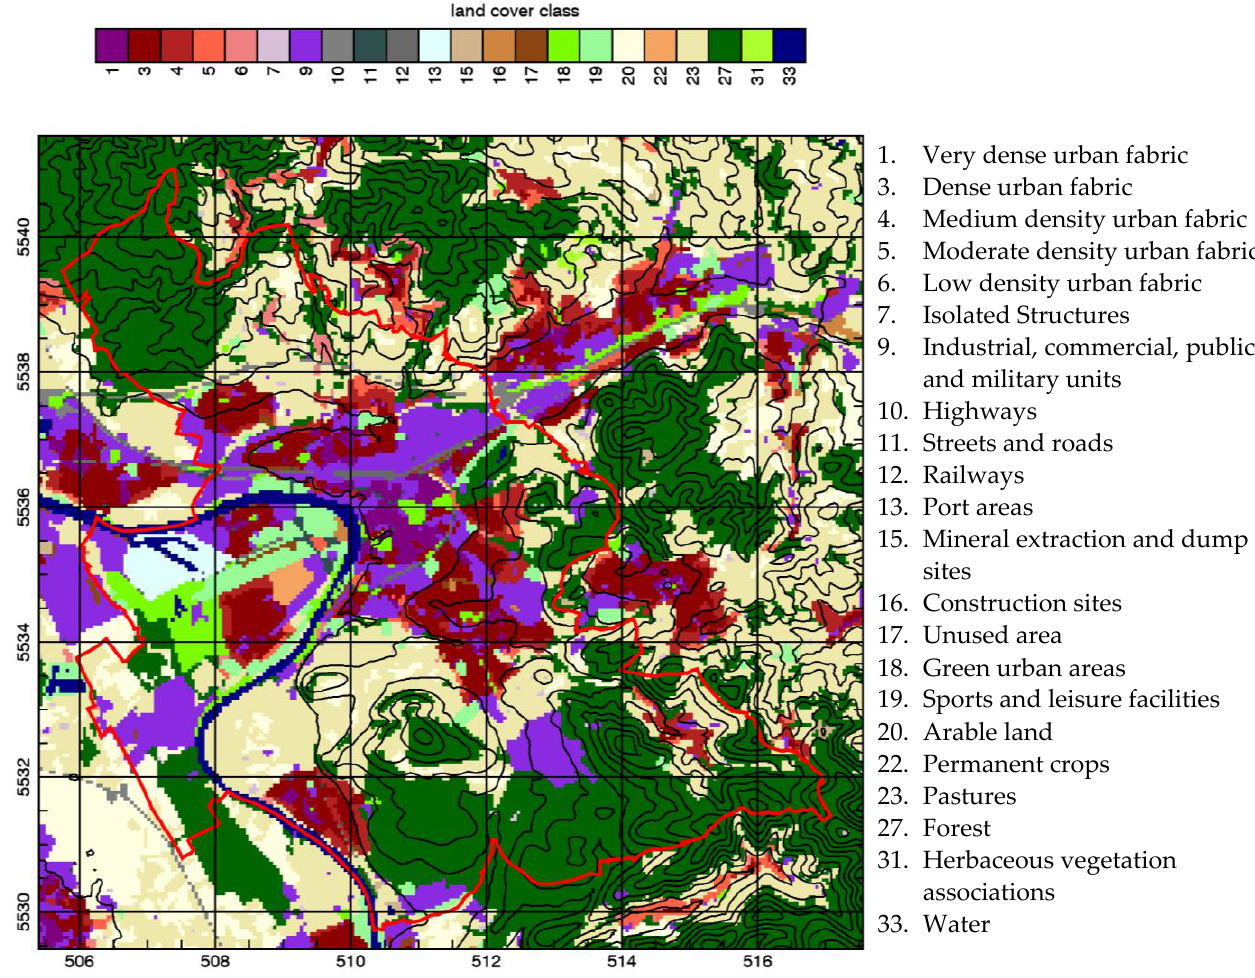
Figure 3. Land cover classification map in the 12 km × 12 km subdomain (see Figure 2a) with the city border of Aschaffenburg (red line). Black contour lines represent terrain elevation in 25 m height intervals.